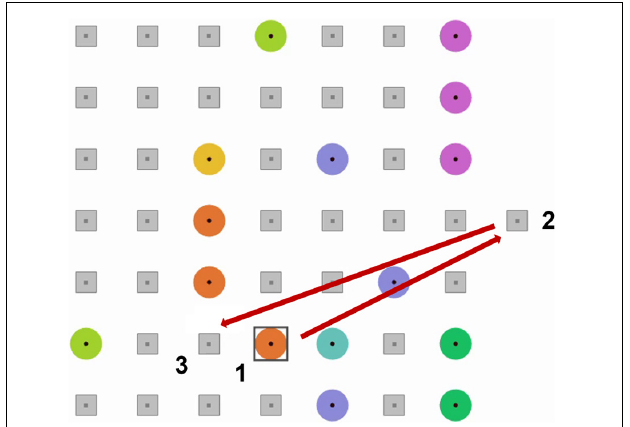
FIGURE 1 | An example of EyeLine game board display and an example of a sequence of eye fixations needed to make a move. 1, a target ball; 2, the confirmatory position; 3, a free cell to which the ball will be re-located. A square frame appeared around a ball when it was fixated for more than 500